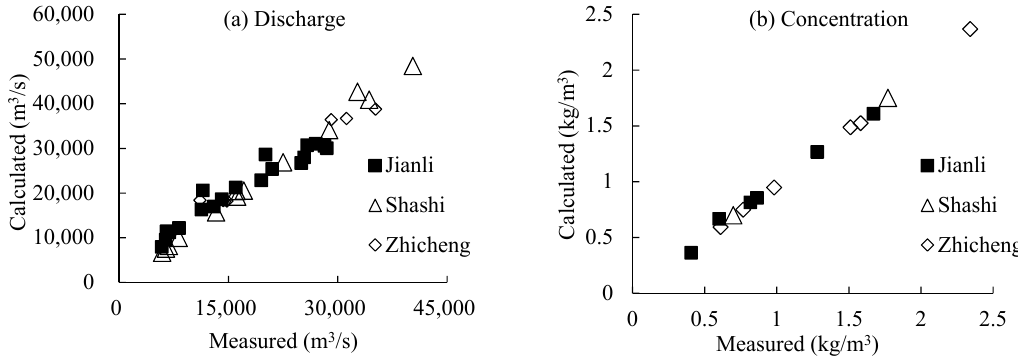
Figure 15. Comparison between measured and calculated sectional discharge ( a ) and concentration ( b ).